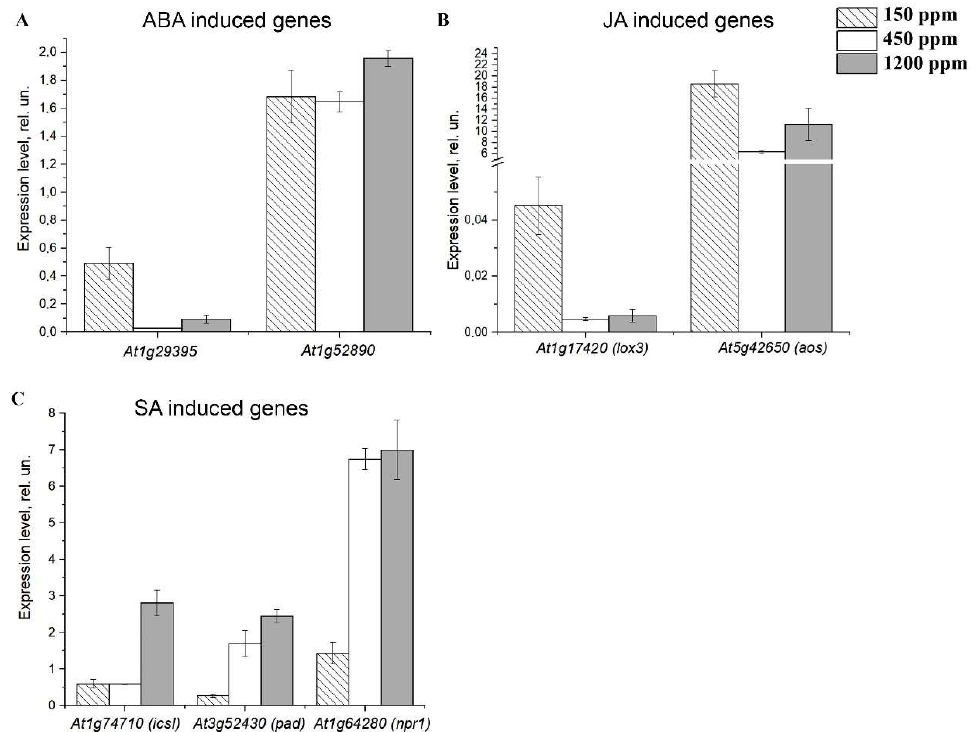
Figure 2. The content of transcripts of the genes inducible by plant immune signals in Arabidopsis plant leaves after 16 days of acclimation to low (150 ppm), normal (450 ppm), and high (1200 ppm) CO 2 levels in the air. ( A ) At1g29395 and At1g52890 induced by abscisic acid; ( B ) At1g17420 ( lox3 ) and At5g42650 ( aos ) induced by jasmonic acid; ( C ) At1g74710 ( icsI ), At3g52430 ( pad ) and At1g64280 ( npr1 ) induced by salicylic acid. Data were normalized for actin gene expression. Values are means ± S.E. of three independent experiments each formed by three repetitions.